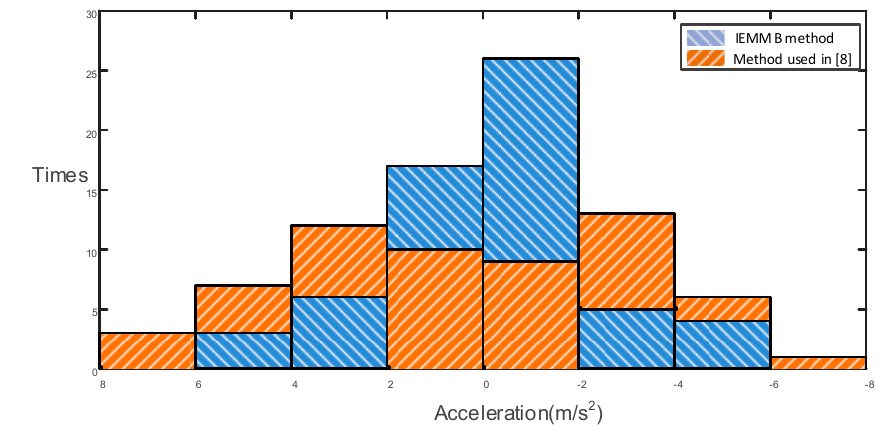
Figure 16. Maximum acceleration during collision avoidance.